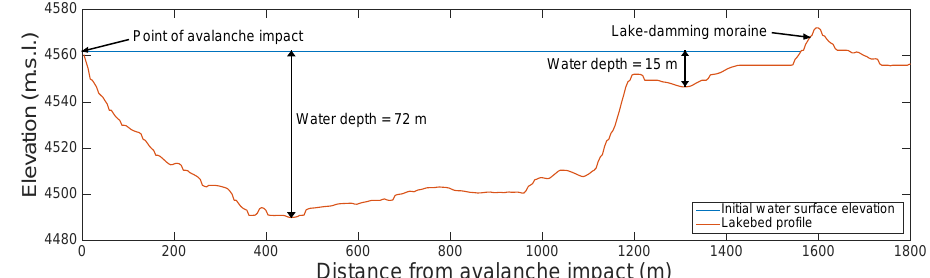
Figure 2. Longitudinal profile of Lake Palcacocha and its terminal